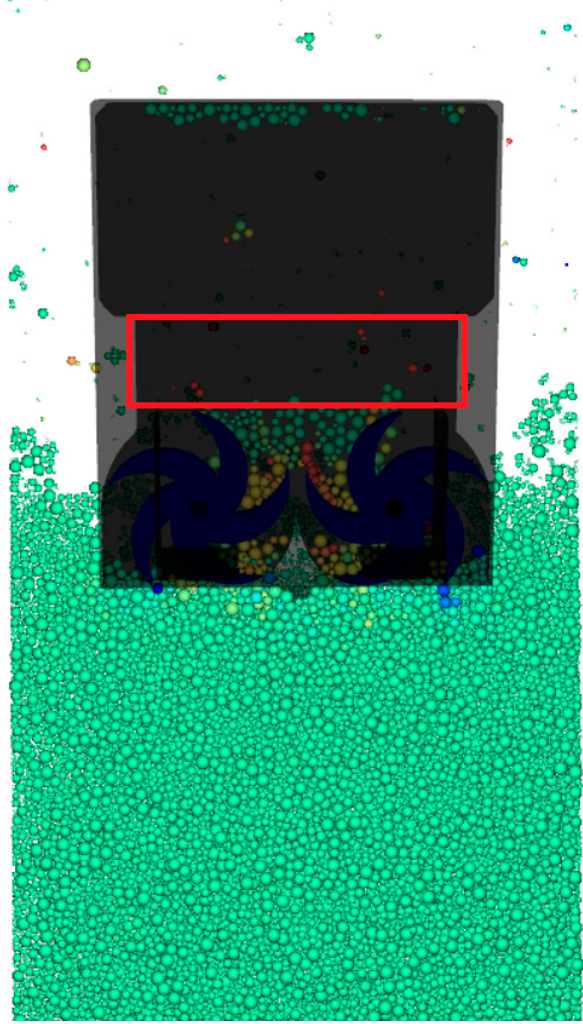
Figure 5. Particle collection process using DEM modeling. The color of the particles indicates their linear velocity. Red box presents the place where the collected particles are calculated.